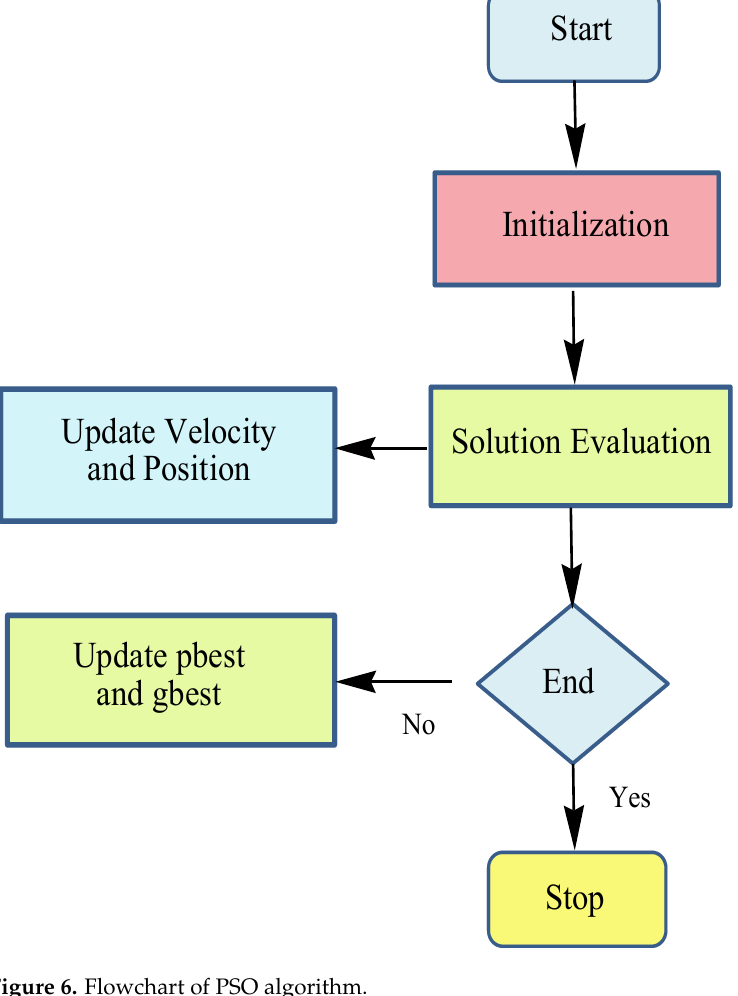
Figure 6. Flowchart of PSO algorithm.